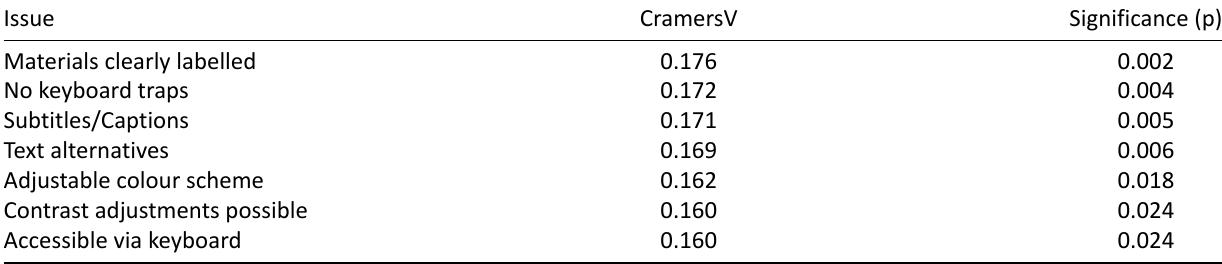
Table 1. Significant differences between students with and without impairments, differentiated between different impair‐ ment types (Degree